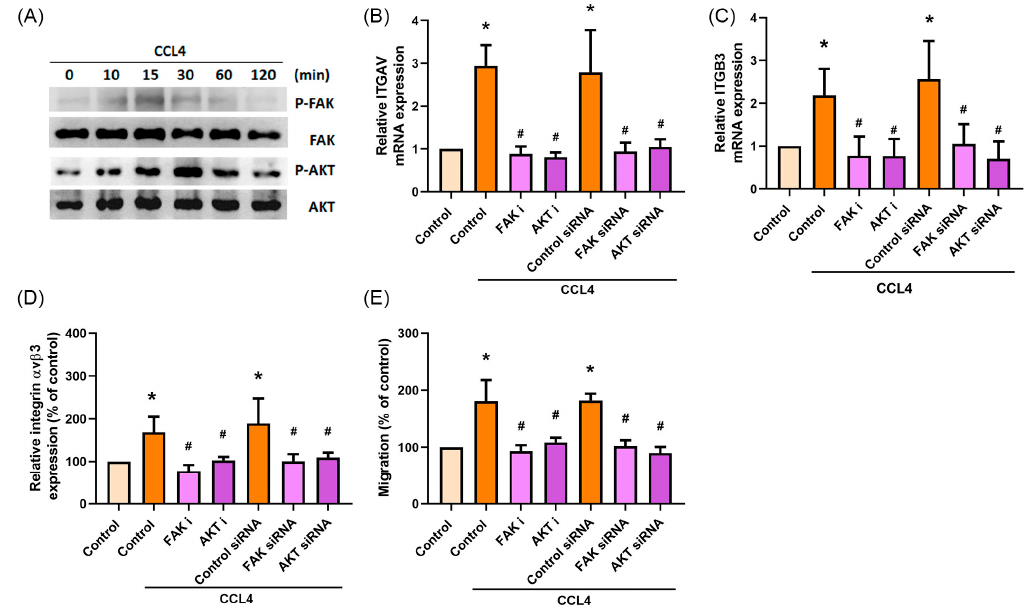
Figure 4. CCL4 promotes cell migration by activating FAK and AKT signaling. ( A ) 143B cells were incubated with CCL4 (30 ng/mL) for the indicated time intervals, then FAK and AKT activation was examined by the Western blot assay. ( B – E ) 143B cells were treated with a FAK inhibitor (FAK i, 10 µ M) or AKT inhibitor (AKT i, 10 µ M) for 30 min, or transfected with FAK or AKT siRNAs, then stimulated with CCL4 (30 ng/mL) for 24 h. Levels of ITGAV mRNA ( B ) and ITGB3 mRNA expression ( C ), cell surface integrin α v β 3 protein expression ( D ), and cell migratory abilities ( E ) were examined by qPCR, flow cytometry, and the Transwell assay, respectively. The results were obtained from three independent experiments and are expressed as the means ± SD. * p < 0.05 compared with controls; # p < 0.05 compared with CCL4-treated controls.